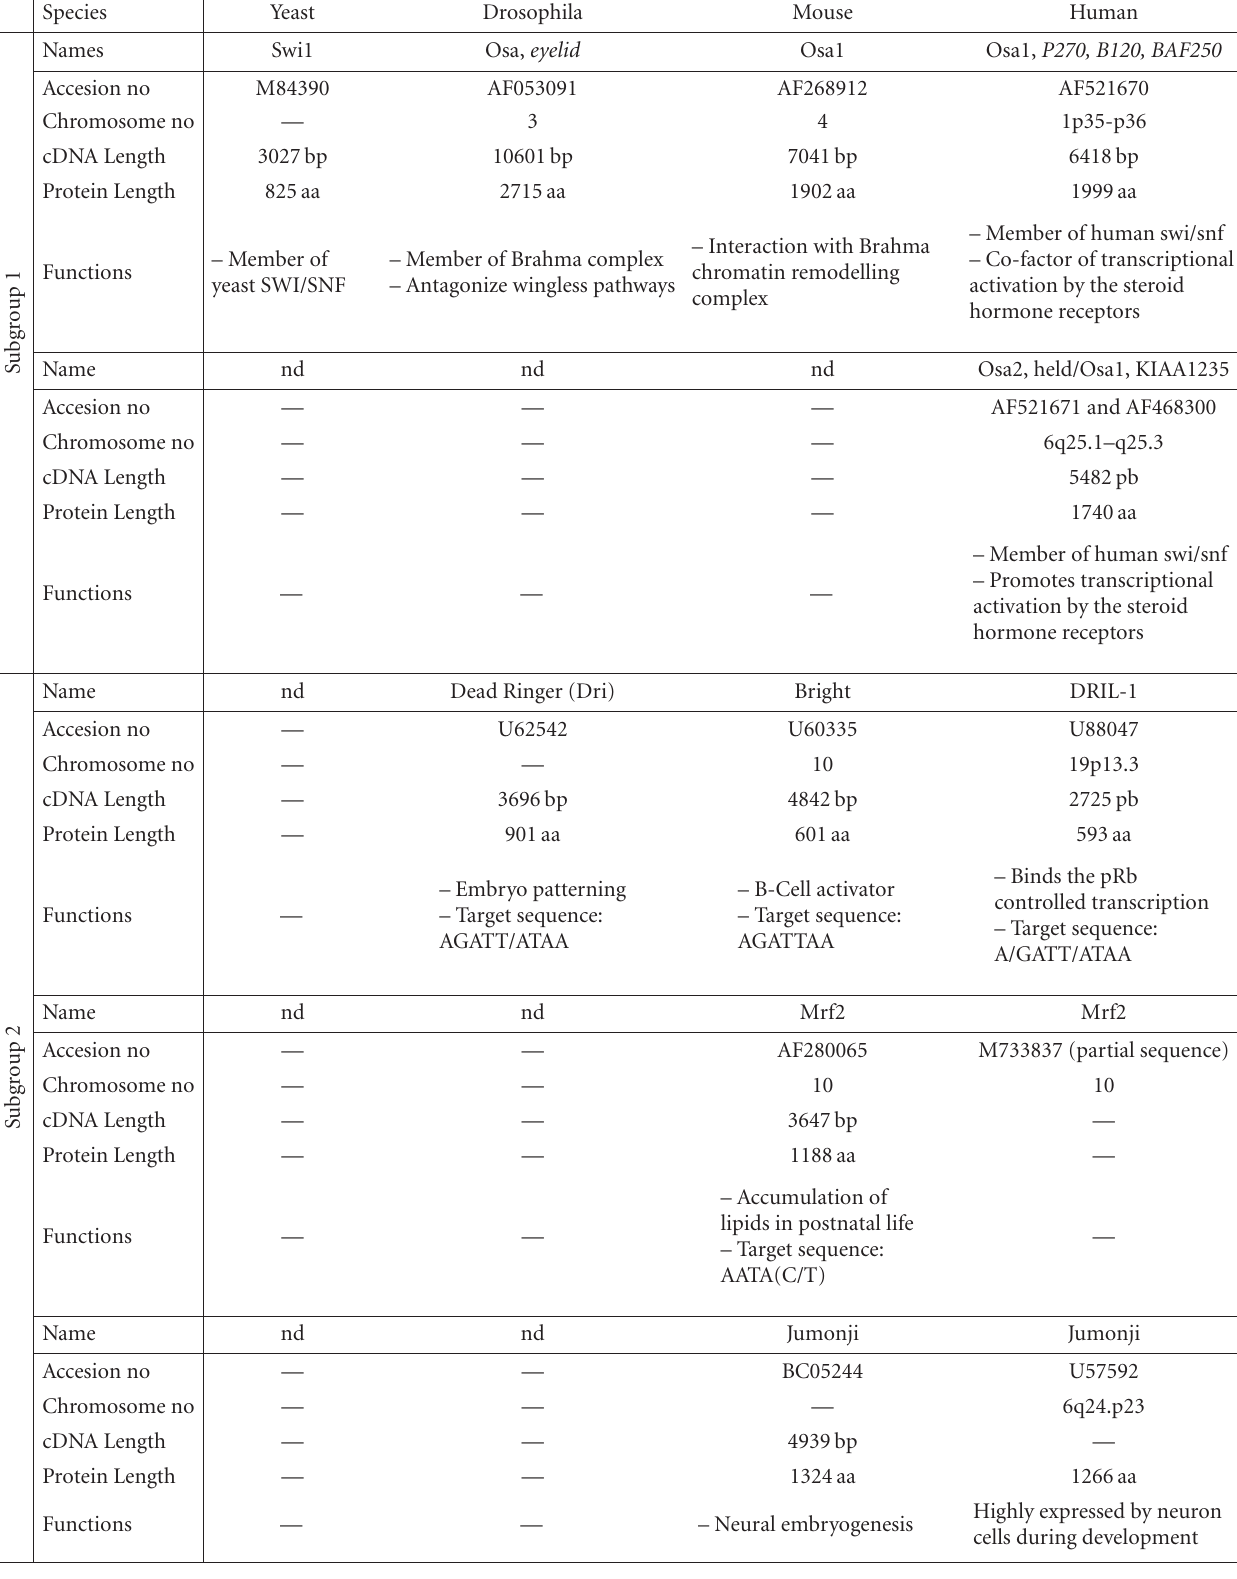
Table 1: Homologies of rat 6A3-5 sequences with ARID proteins. Homologues are divided into two subgroups. The first subgroup, which would define the subfamily called Osa, has members bearing an ARID motif and two OHD domains. The second subgroup indicates di ff erent ARID